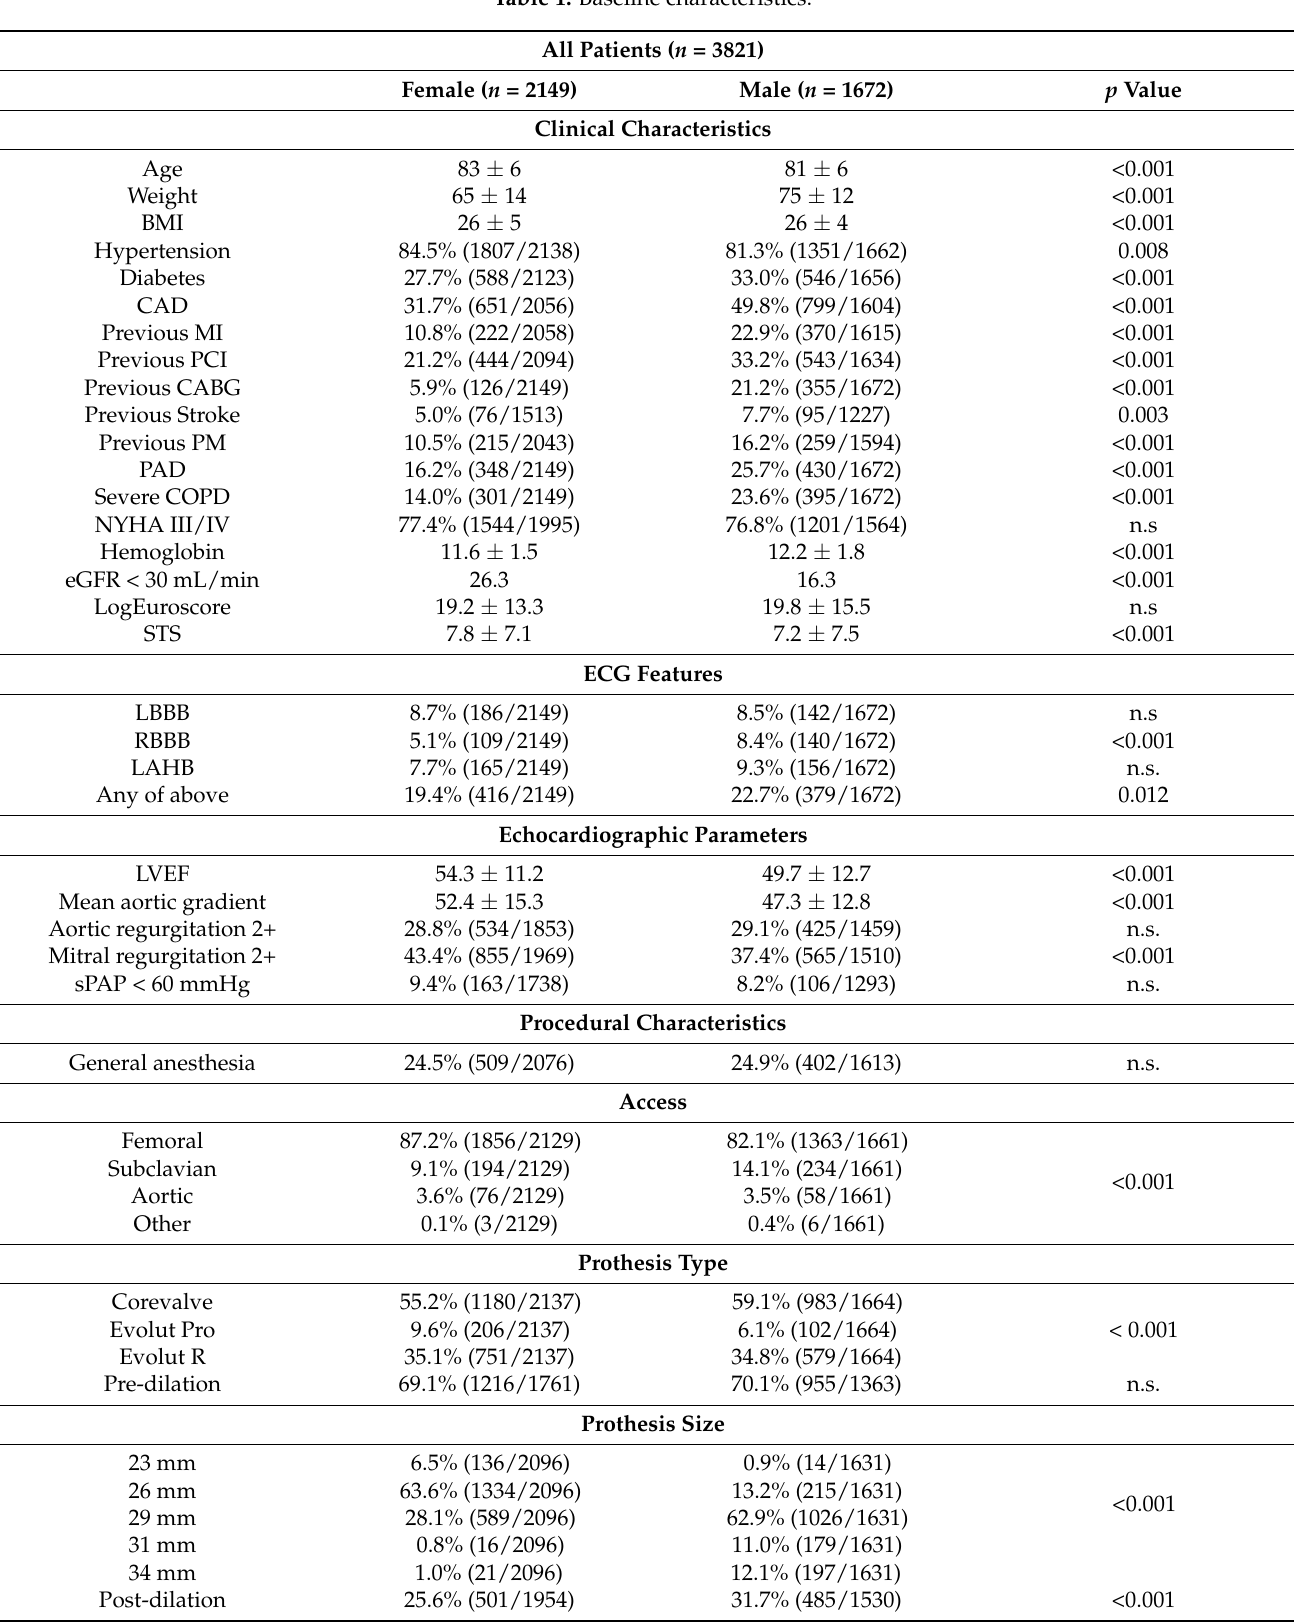
Table 1. Baseline